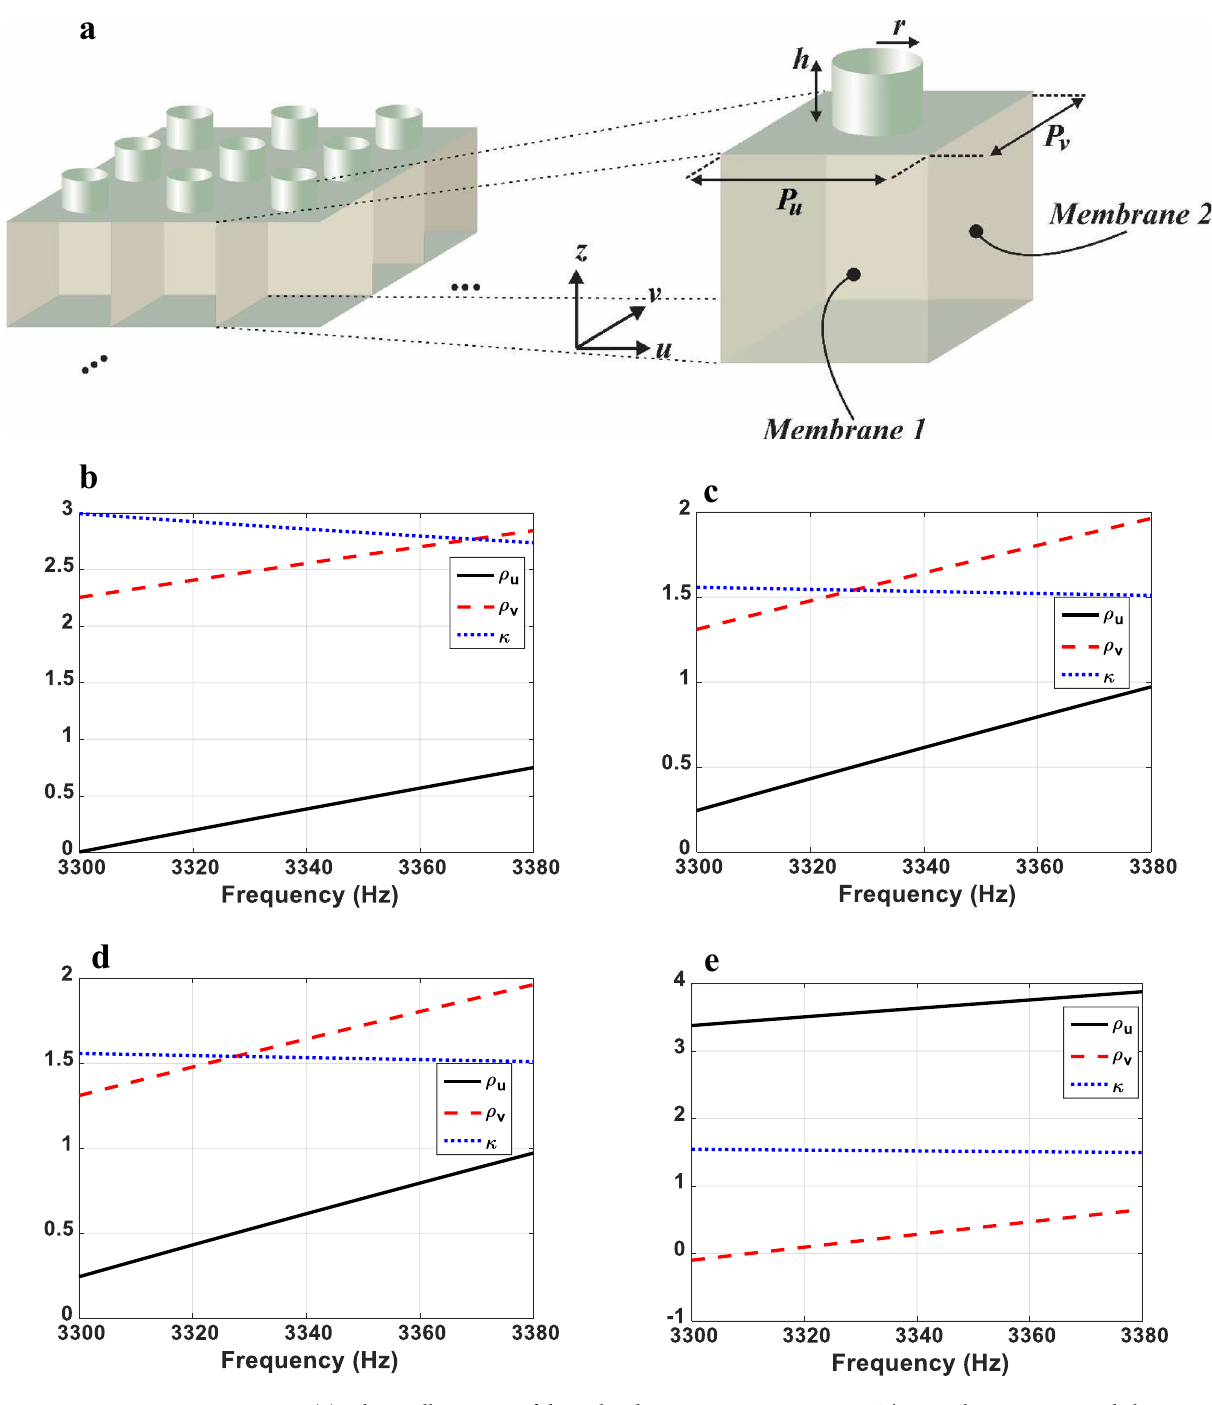
Figure 8. ( a ) Scheme illustration of the utilized non-resonant meta-atom. The membrane in repeated along u and v directions with periodicity p u = p v = 4 mm . The retrieved parameters for all regions are shown in ( b – i ). ( b – d ) Real parts of retrieved parameters of region 1. For (cid:31) BA ′ C ′ , the thickness of membranes’ faces are th u = 6.368 µ m and th v = 5.387 µ m . The radius and height of the side branch are r = 0.4 mm and h = 2.958 mm , respectively. For (cid:31) BK ′ E : th u = 5.859 µ m , th v = 6 µ m , r = 0.4 mm and h = 6.11 mm . For (cid:31) BA ′ K ′ , th u = 10.5 µ m , th v = 6.53 µ m , r = 1.2 mm and h = 1 mm . ( e , f ) Real parts of retrieved parameters of region 2. For (cid:31) BMC ′ : th u = 4.603 µ m , th v = 6.41 µ m , r = 0.4 mm and h = 6.11 mm and for (cid:31) ENA ′ , th u = 6.36 µ m , th v = 5.4 µ m , r = 0.4 mm and h = 6.11 mm . ( g ) Real parts of retrieved parameters of region 3. For GHC ′ A ′ region, th u = 8.02 µ m , th v = 6.57 µ m , r = 0.4 mm and h = 0.94 mm . ( h , i ) Real parts of retrieved parameters of region 4. For (cid:31) MC ′ G : th u = 6.986 µ m , th v = 6.471 µ m , r = 0.4 mm and h = 0.94 mm and for (cid:31) NA ′ H , th u = 8.611 µ m , th v = 6.553 µ m , r = 0.4 mm and h = 0.94 mm